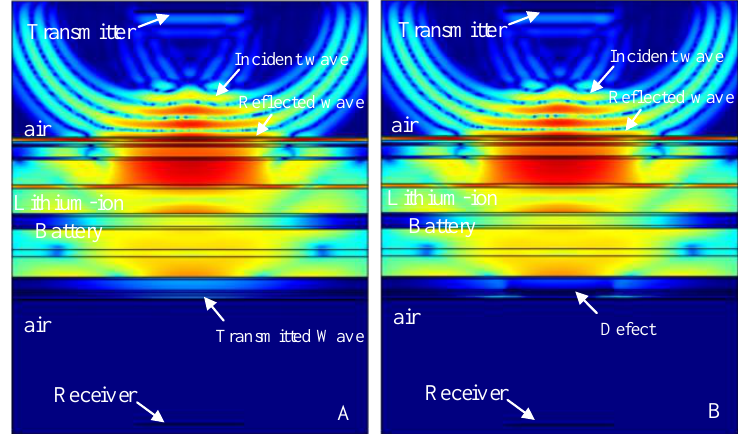
Figure 16. Finite element simulation of time snapshots of the propagation of the ultrasonic wave in the lithium- ion battery (12.996 μs). ( A ) The simulation result without a defect; ( B ) the simulation result with a stomata defect in the fifth electrolyte layer.